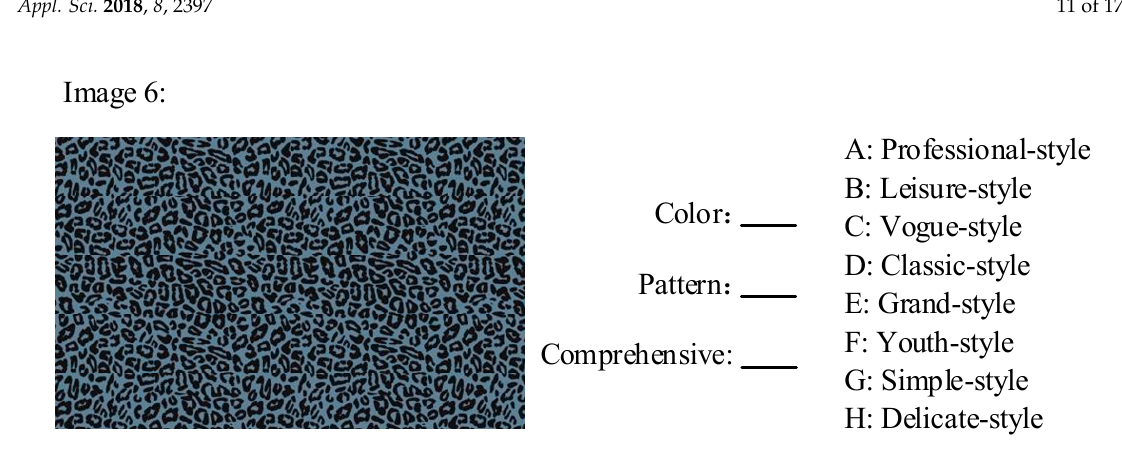
Figure 8. One of the questionnaires.